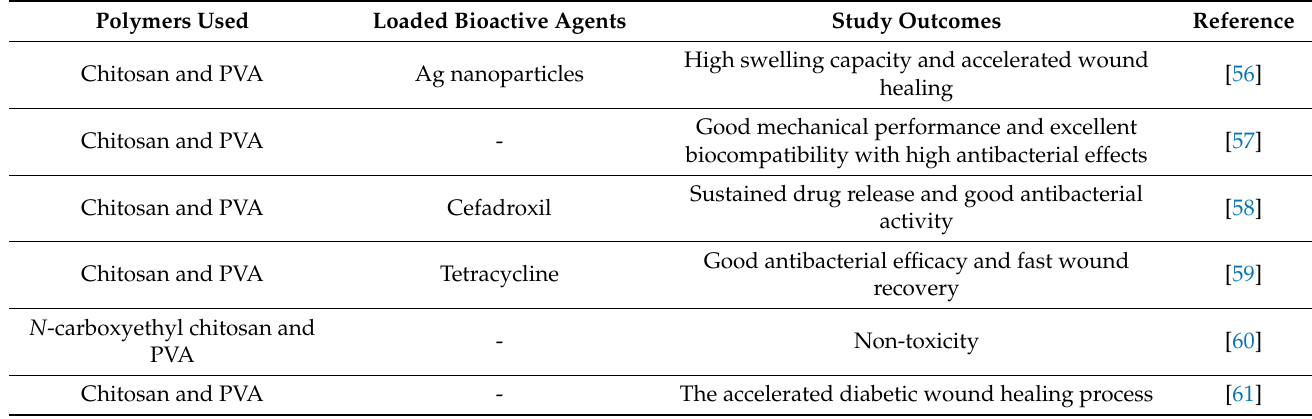
Table 1. Summary of biopolymer-based hybrid nanofibrous scaffolds. Polymers